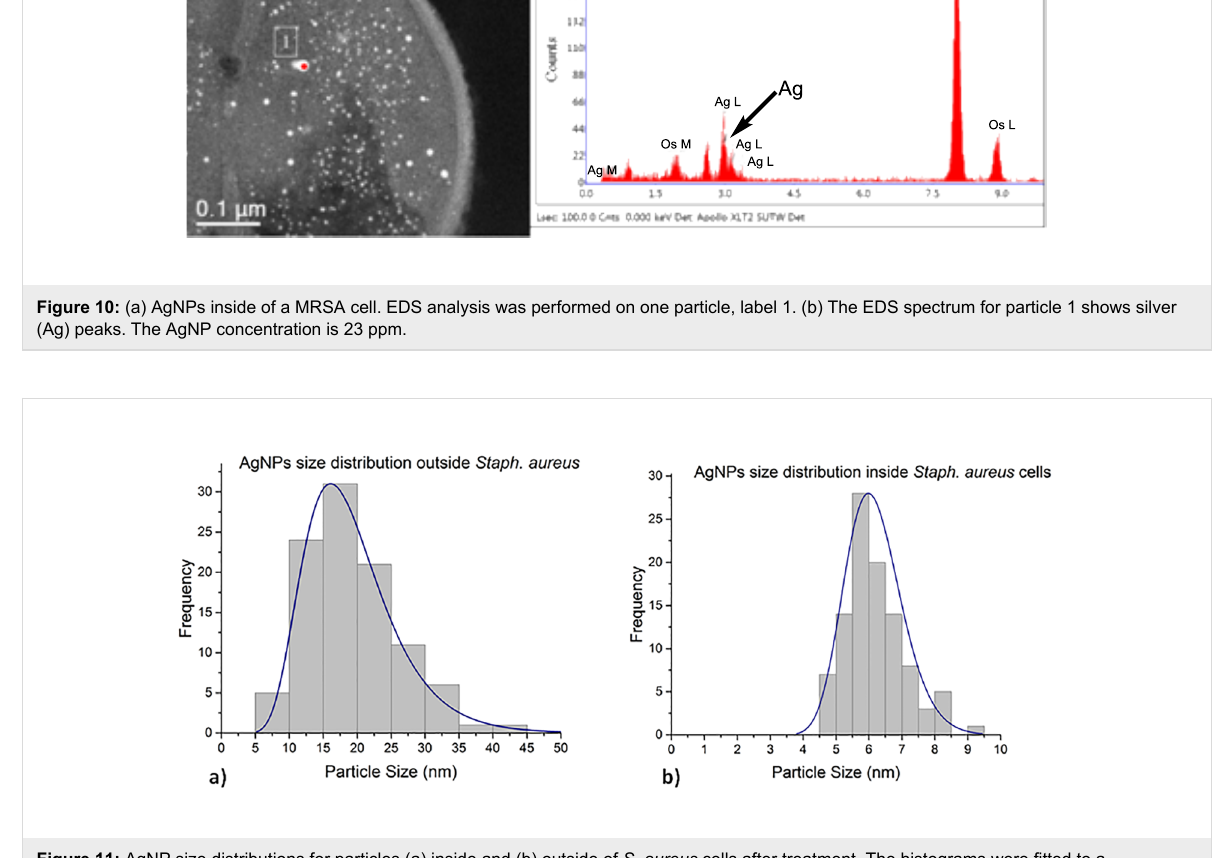
Figure 11: AgNP size distributions for particles (a) inside and (b) outside of S. aureus cells after treatment. The histograms were fitted to a log–normal size